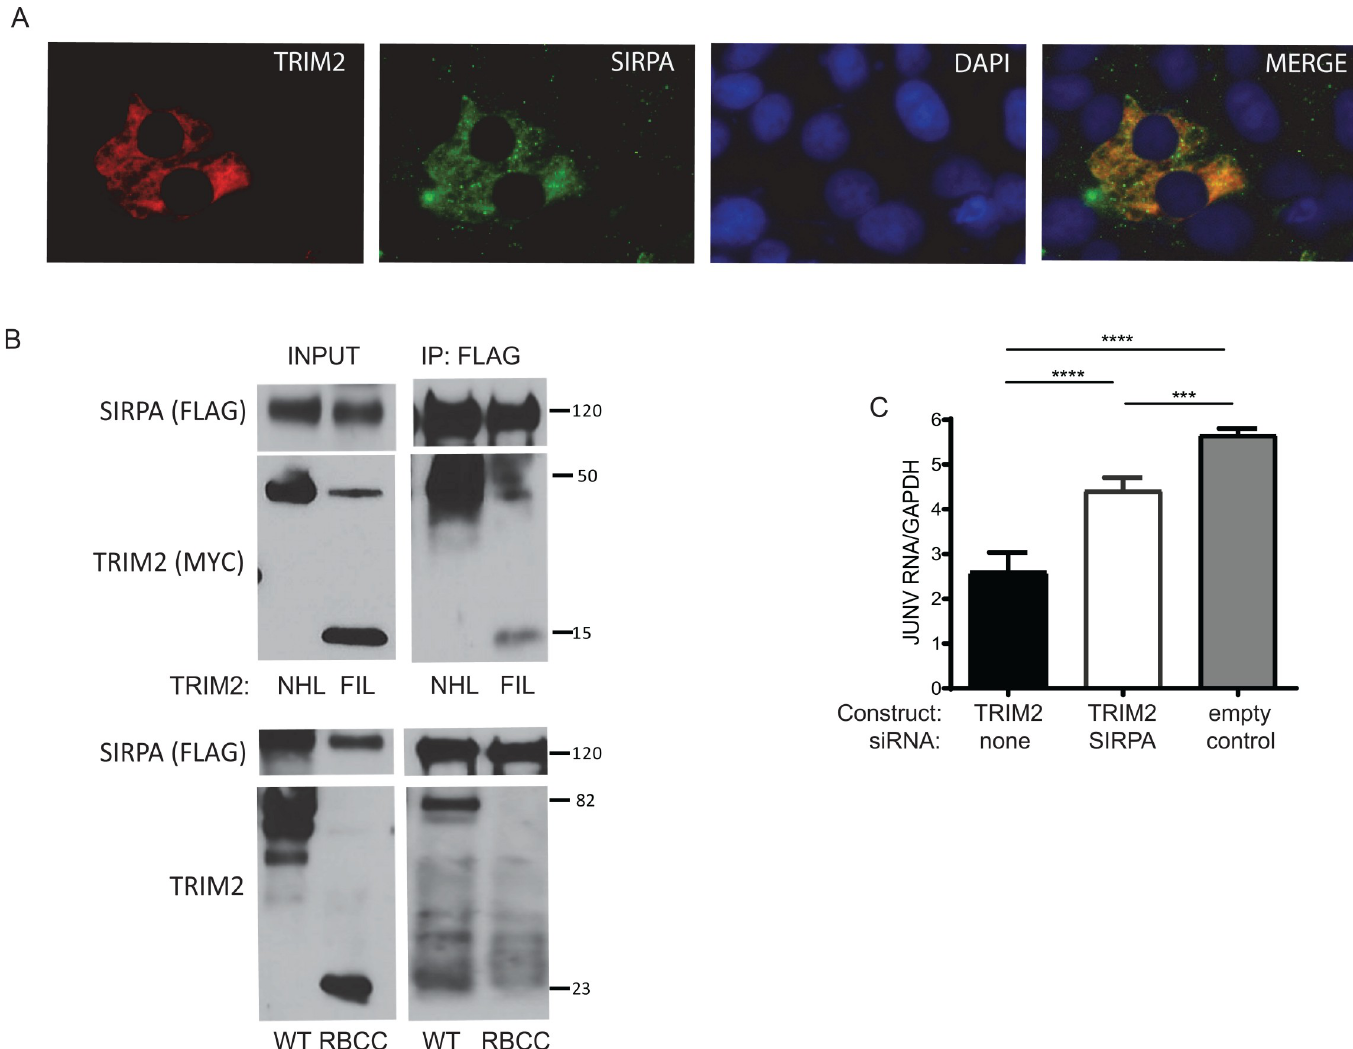
Fig 7. TRIM2 and SIRPA interaction blocks infection. (A) U2OS cells were cotransfected with TRIM2 and SIRPA expression constructs, and immunofluorescence analysis was performed with antibodies against each protein. (B) U2OS cells were cotransfected with myc-tagged TRIM2 or the FIL, NHL, or RBCC constructs (Fig 5A) and FLAG-tagged SIRPA and were immunoprecipitated with anti-FLAG antisera, and blots were subjected to probing with anti-FLAG or anti-myc antisera (top panel) or anti-TRIM2 antisera (bottom panel). (C) U2OS cells were treated with SIRPA siRNA and 24 hr later transfected with the TRIM2 expression vector. Then, 24 hr later, the cells were infected with Candid 1 (MOI 0.1) and reverse-transcribed RT-qPCR for the NP was analyzed. Knockdowns are shown in S6D Fig. Values represent the average of 4 independent experiment ± SD. Statistical significance was calculated by one-way ANOVA. ��� P � 0.001; ���� P � 0.0001. IP, immunoprecipitation; JUNV, Junı´n virus; MOI, multiplicity of infection; RT-qPCR, real-time quantitative PCR; WB, western blot; WT, wild type.